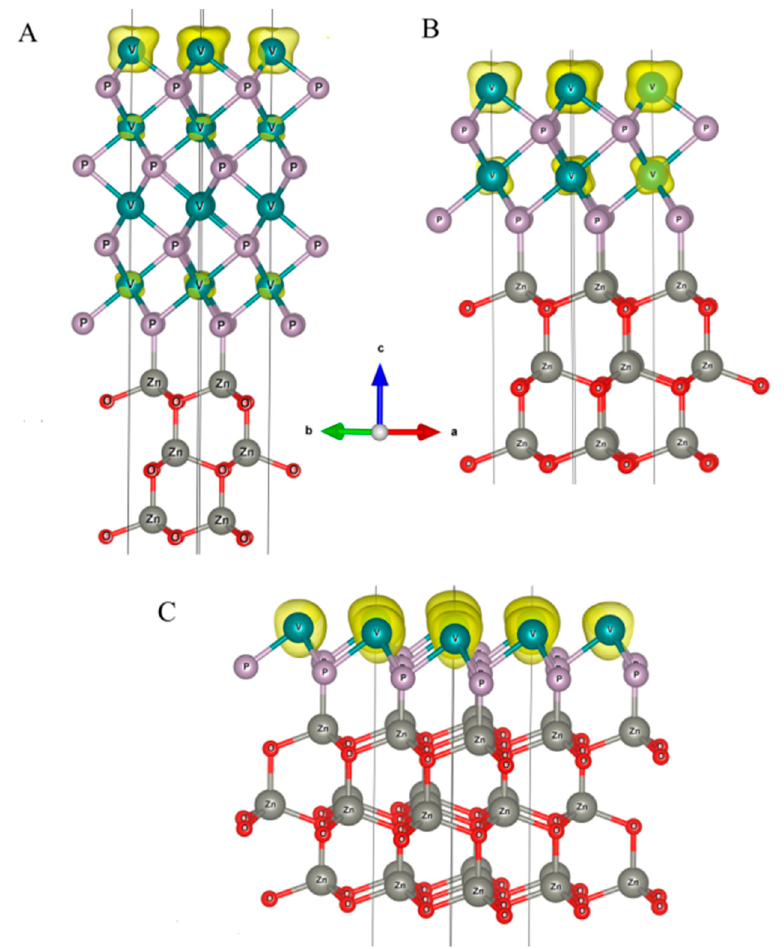
Figure 8. Spin density distribution in VP/ ZnO composites with four ( A ), two ( B ) and one layer ( C ) of VP. ( C ) of